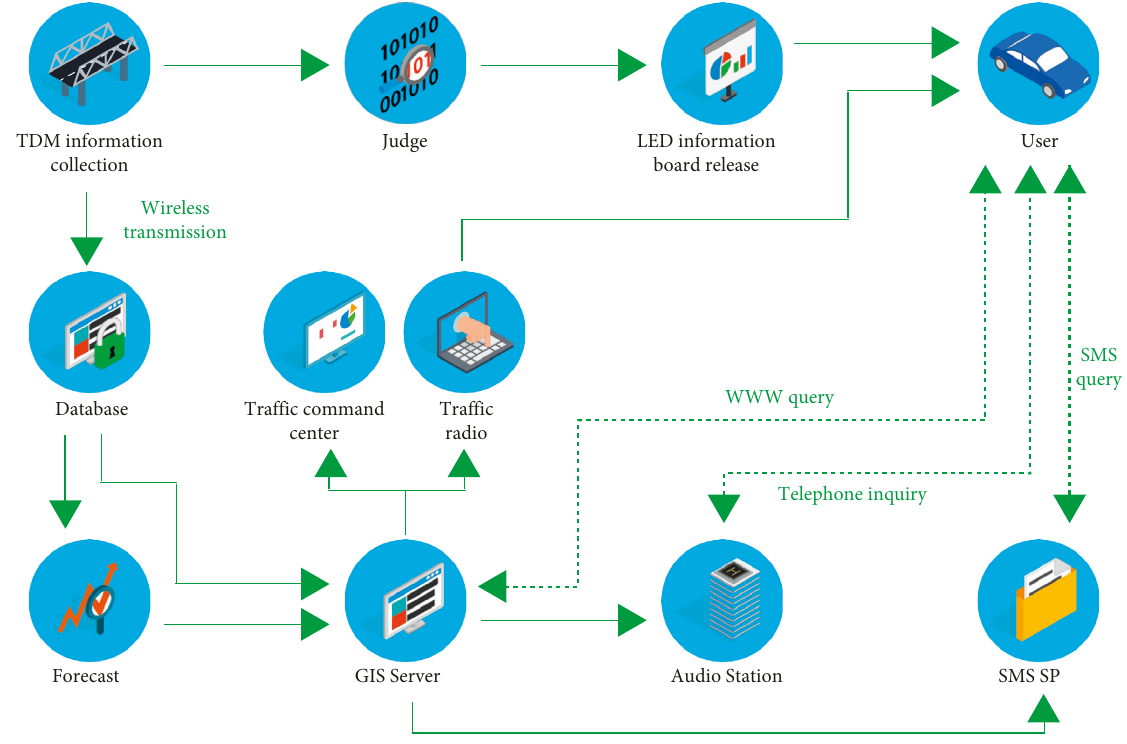
Figure 1: System implementation flow